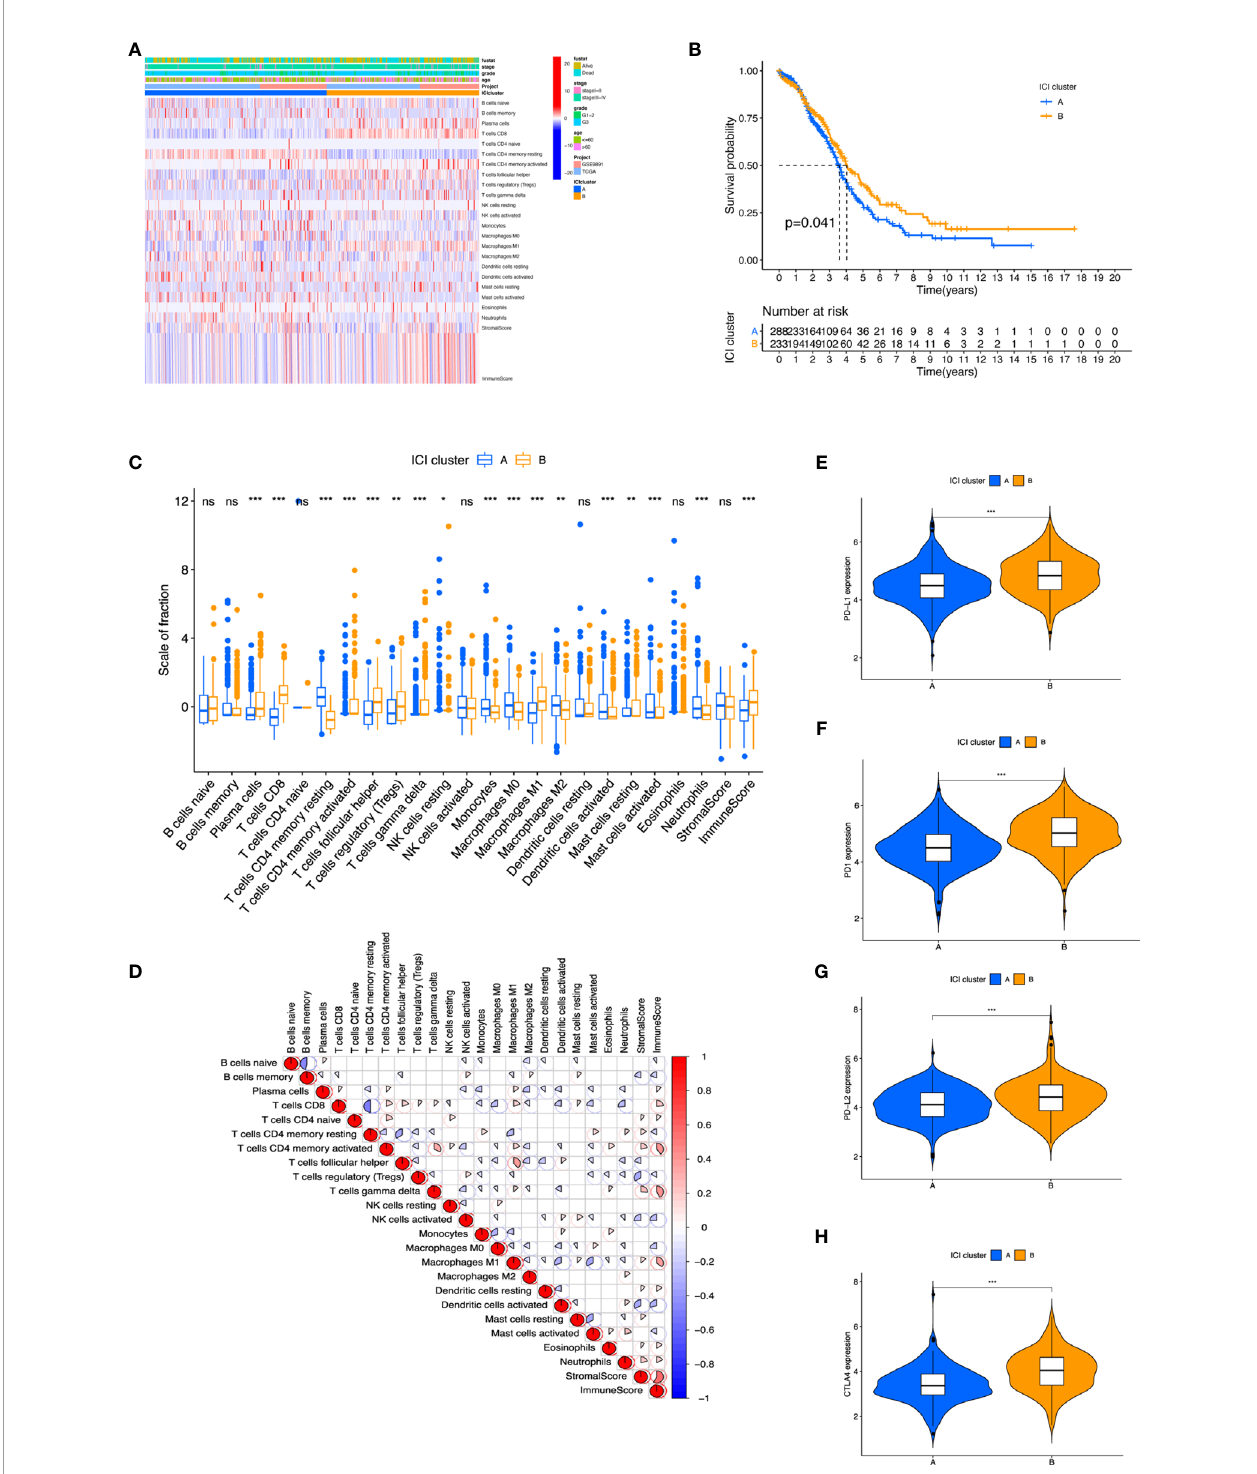
FIGURE 2 | The landscape of Immune cells in fi ltration in the TME of OC. (A) Heatmap representing unsupervised clustering of in fi ltrating immune cells in two OC cohorts. (B) Kaplan – Meier curves showed OS of all patients between two ICI clusters. (C) The fraction of tumor-in fi ltrating immune cells and immune and stromal scores in the two ICI clusters. (D) Cellular fraction of the tumor-in fi ltrating immune cell types in ICI clusters. (E – H) Difference in PD-L1 (E) , PD1 (F) , PD-L2 (G) , and CTLA4 (H) expression between ICI clusters. * p < 0.05; ** p < 0.01; *** p < 0.001; ns, not signi fi